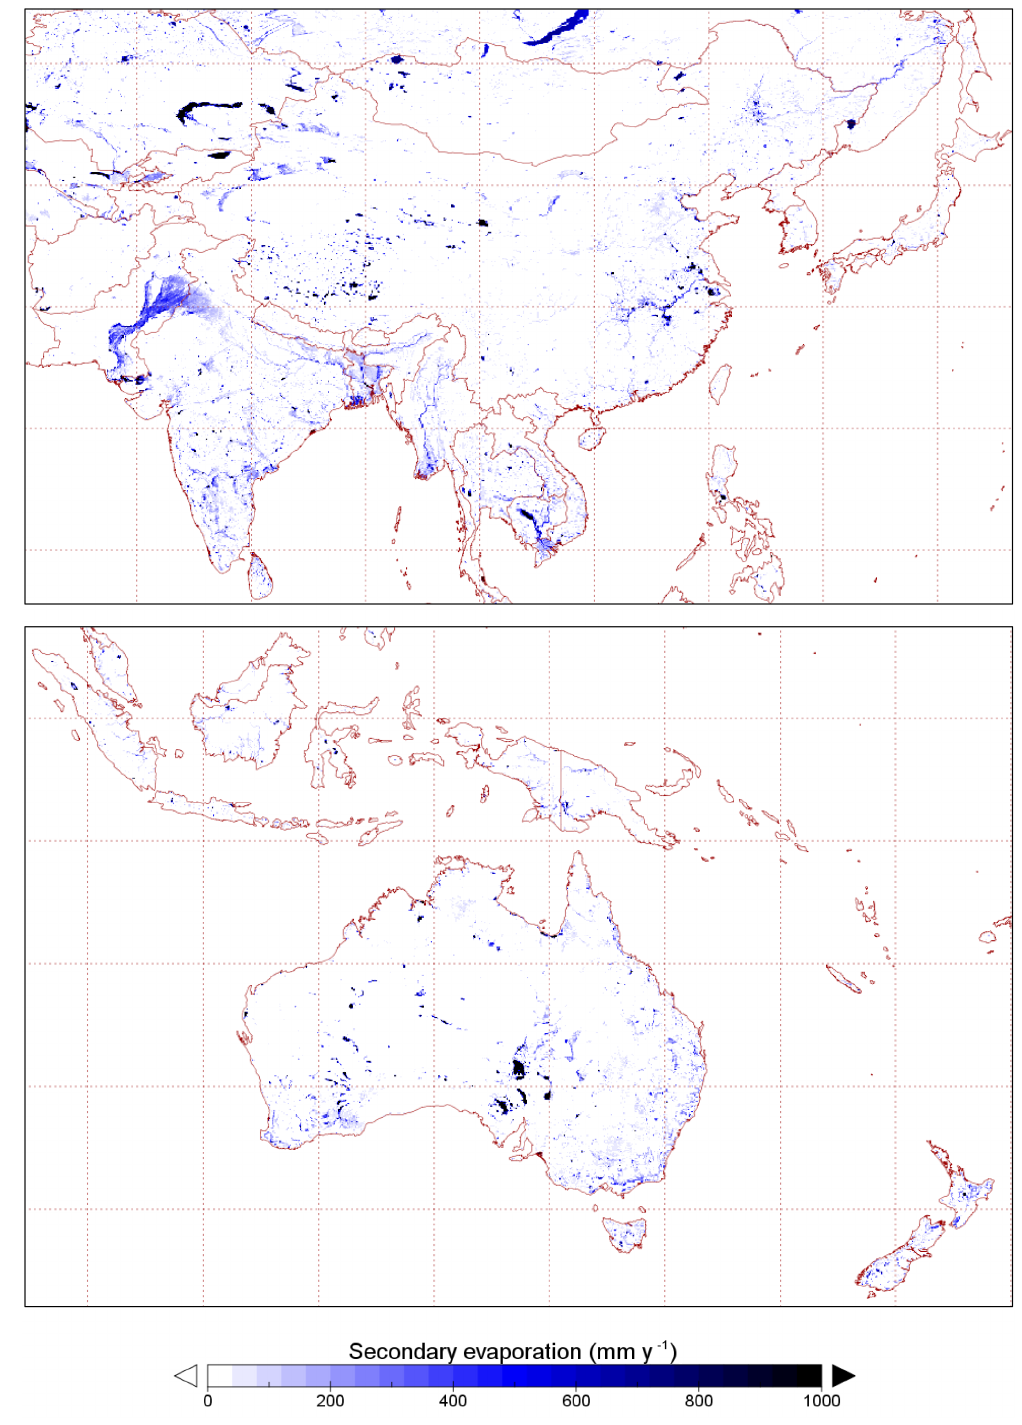
Figure 10. Spatial distribution of secondary evaporation losses in eastern Asia and